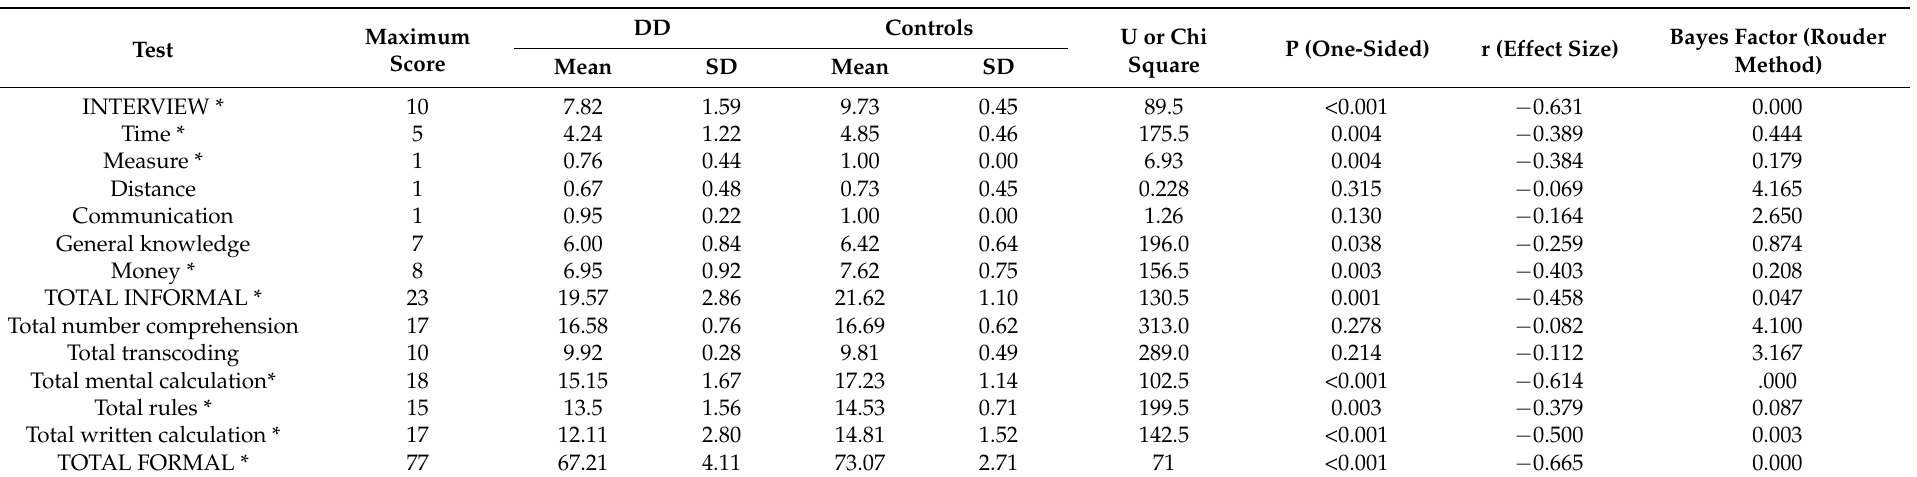
Table 1. Performances of people with DD and controls in the NADL